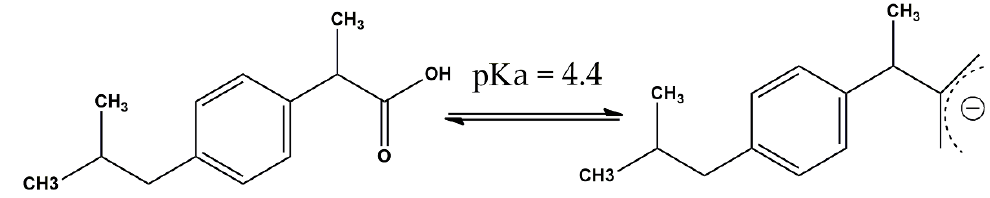
Figure 11. Ibuprofen structures in protonated neutral ( left ) and deprotonated form ( right ).